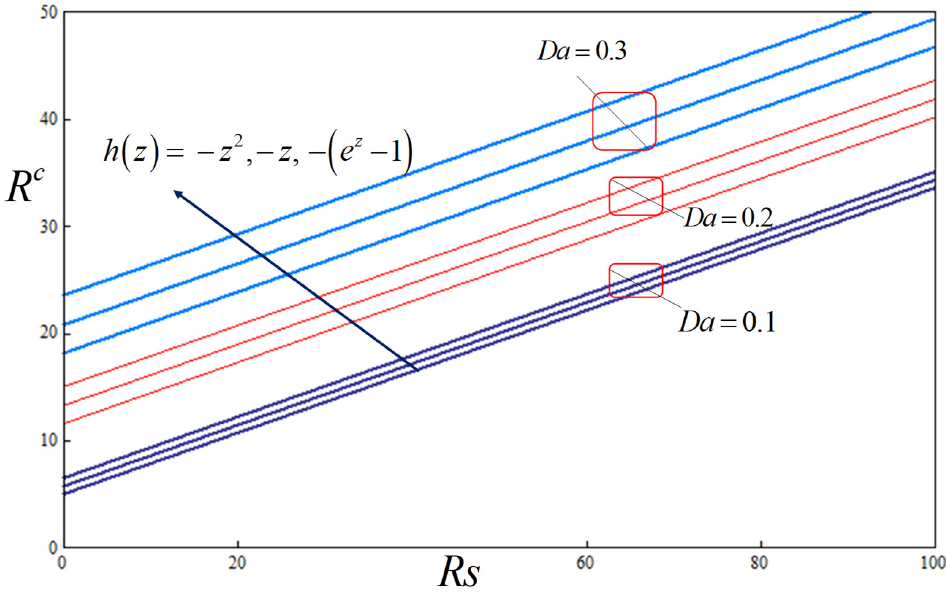
Figure 11. Plot of R c versus Rs for different cases of negative variable gravity functions for various values of Da with Le = 0.5, Rs = 10, ξ = 0.5, η = 0.5 and δ = 0.5.